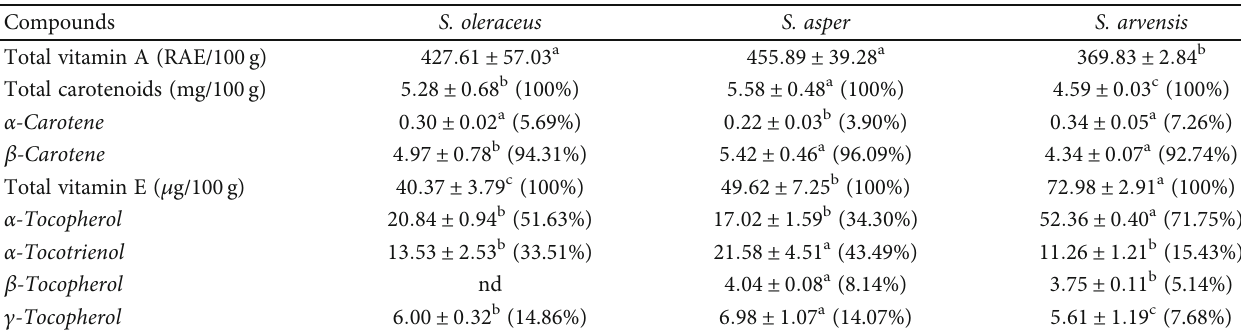
Table 2: Concentrations of carotenoids and vitamins in Sonchus species.